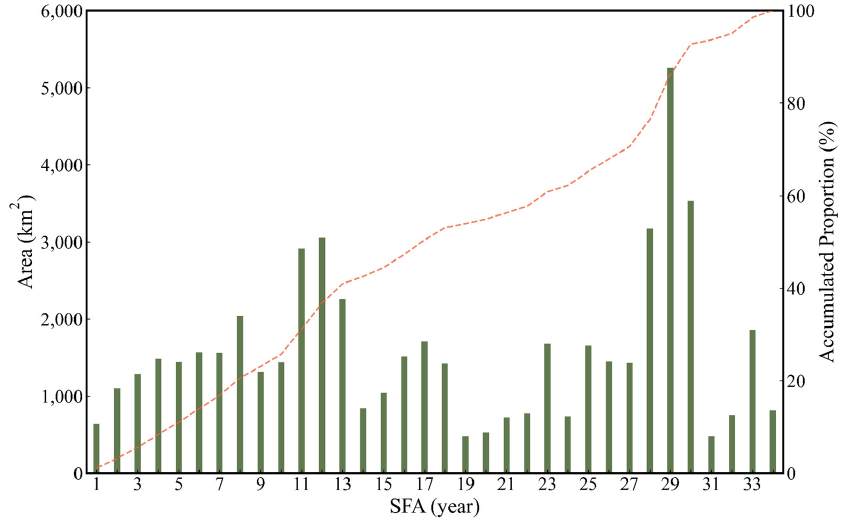
Figure 8. Area age classes in the 2021 SFA map in Jiangxi province. The orange dotted line represents the accumulated proportion of SFA.